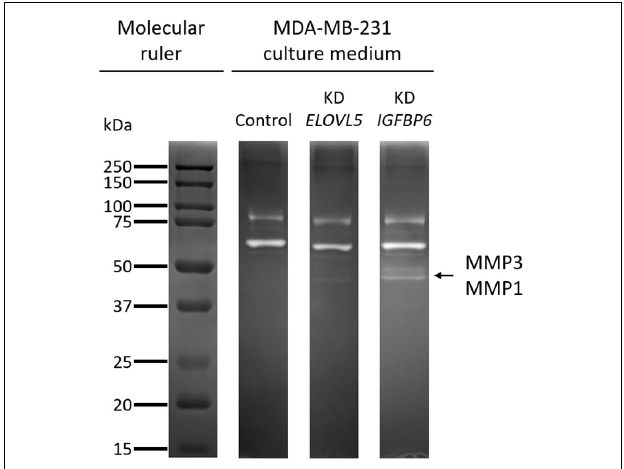
FIGURE 10 | Zymogram of cell culture medium samples obtained after incubation with control MDA-MB-231 (LUC) cells and the cells with a stable knockdown of ELOVL5 and IGFBP6